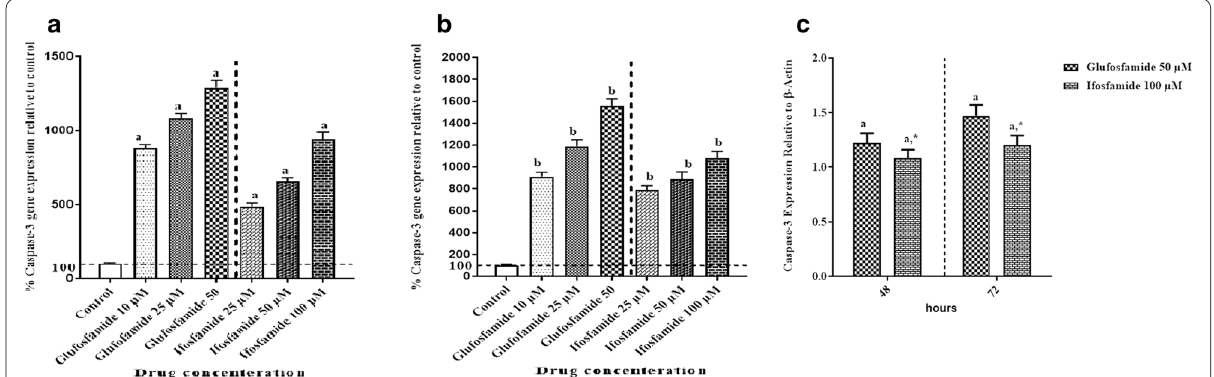
Fig. 4 Effects of glufosfamide and ifosfamide on the expression of caspase-3 gene in HepG2 cells using RT-PCR. a Effects of glufosfamide or ifosfamide on the expression of caspase-3 gene in HepG2 cells at 48 h post-incubation using RT-PCR. b Effects of glufosfamide or ifosfamide on the expression of caspase-3 gene in HepG2 cells at 72 h post-incubation using RT-PCR. c Comparative effects of the IC50 of glufosfamide and ifosfamide on the expression of caspase-3 in HepG2 cells following exposure for 48 and 72